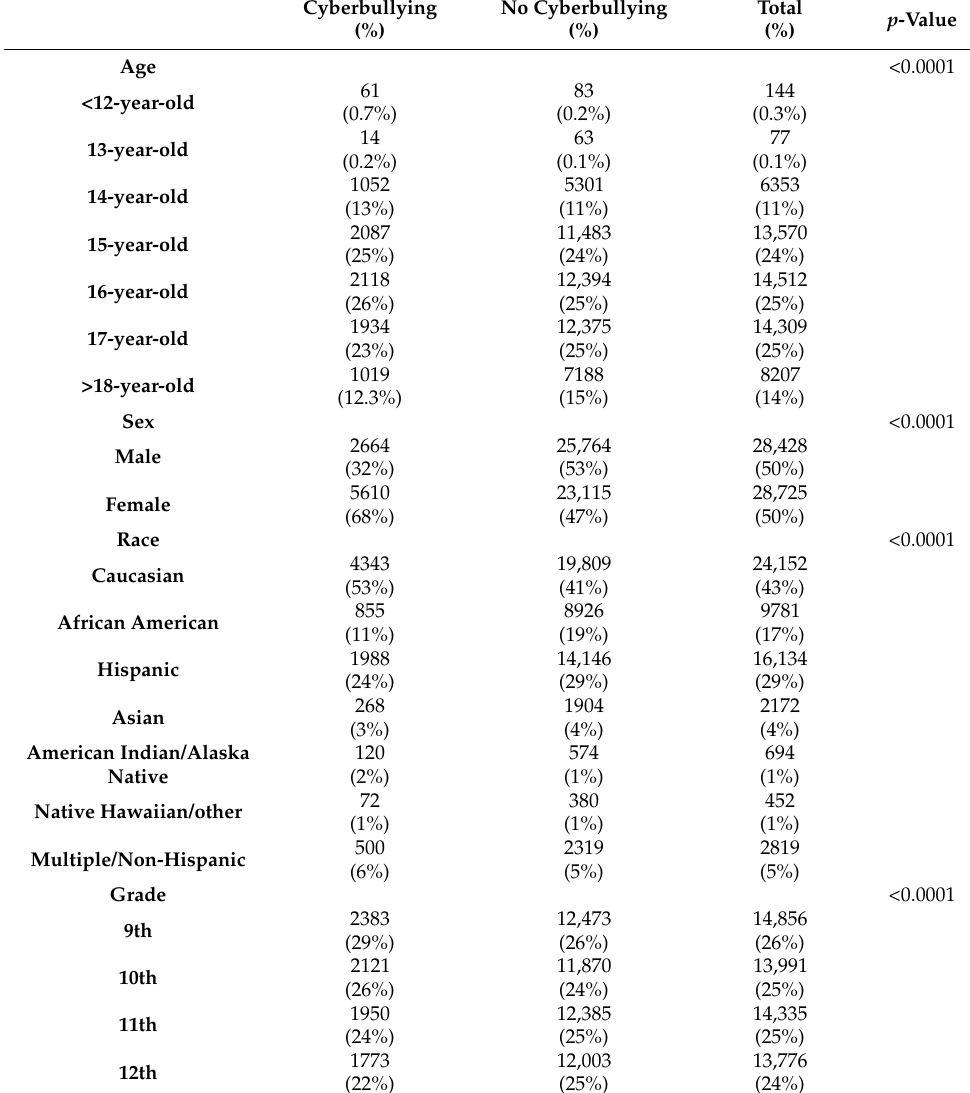
Table 1. Demographics and epidemiological characteristics of adolescent